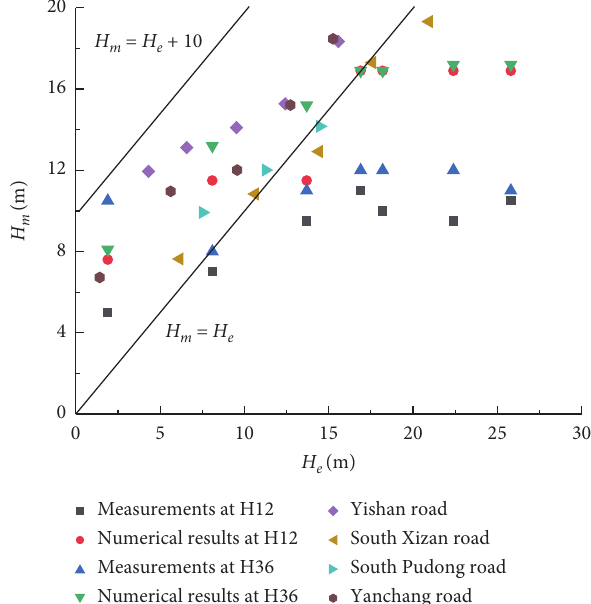
Figure 15: The relationship between the maximum lateral de- formation depth ( H m ) and the excavation depth ( H e ) in this study and other during different excavation stages. Figure 16 shows the simulation results for the four surface settlement monitoring points. The results show that, with excavation, the maximum settlement positions ( V m ) of the different measuring points were not fixed but gradually moved away from the retaining wall, and the settlement profile changed from spandrel to concave. V m of S11 was the closest to the wall, followed by the S20 and S21 measuring points, and V m of S12 was the farthest from the wall. These results are consistent with the conclusions obtained from the measured data.